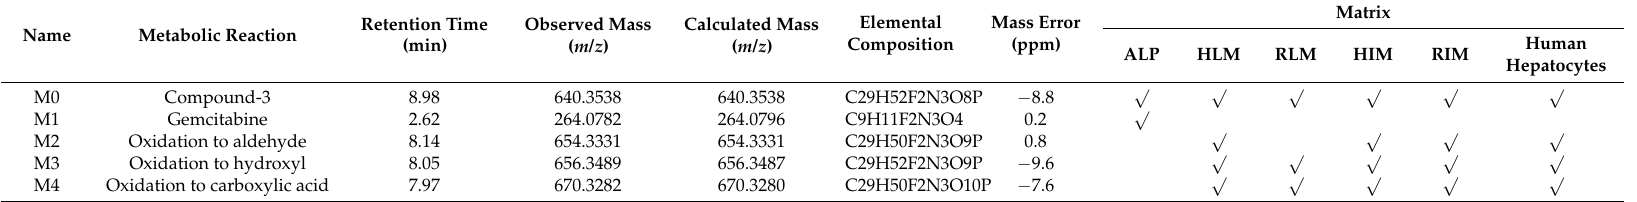
Table 1. Characterization of Compound- 3 metabolites in in vitro incubation systems by UPLC/Triple TOF 5600 +